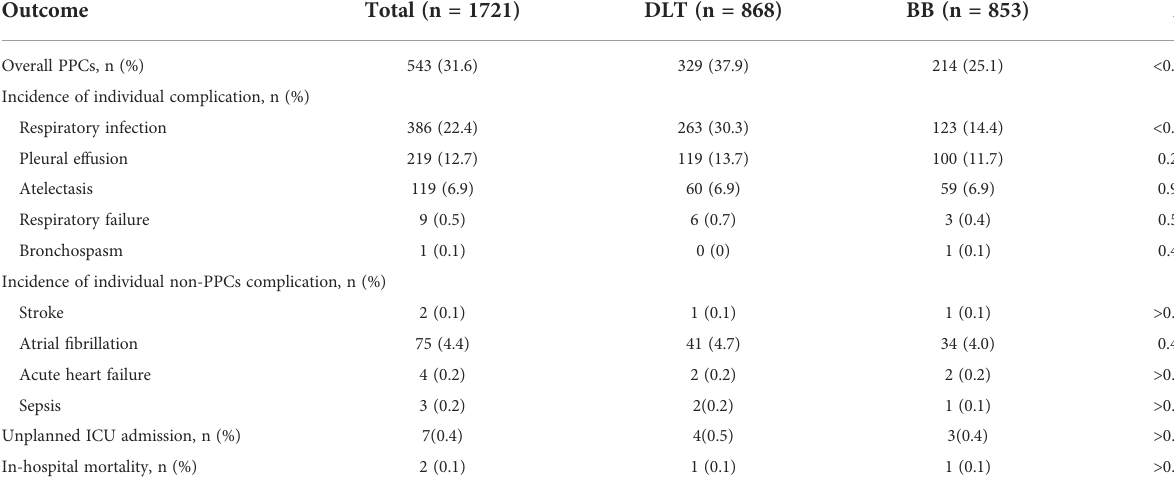
TABLE 3 Primary and secondary